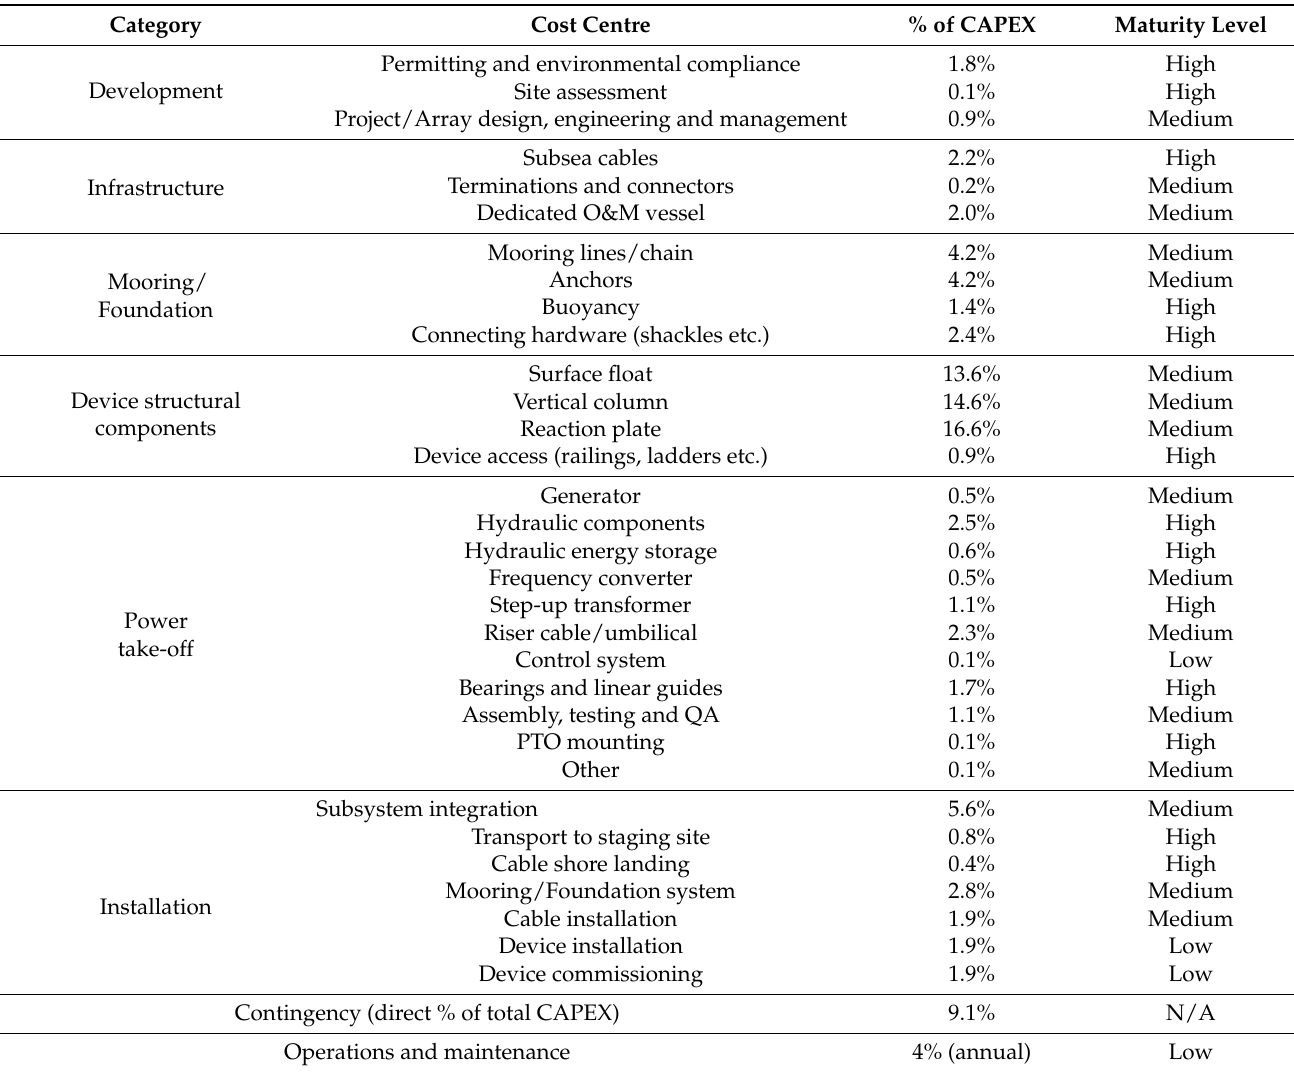
Table 8. Cost centre breakdown and corresponding component maturity levels assumed for wave (point absorber), cost data based on